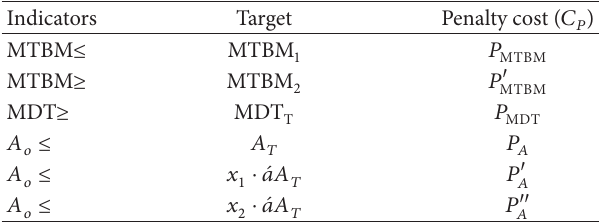
Table 4: Penalty cost for poor